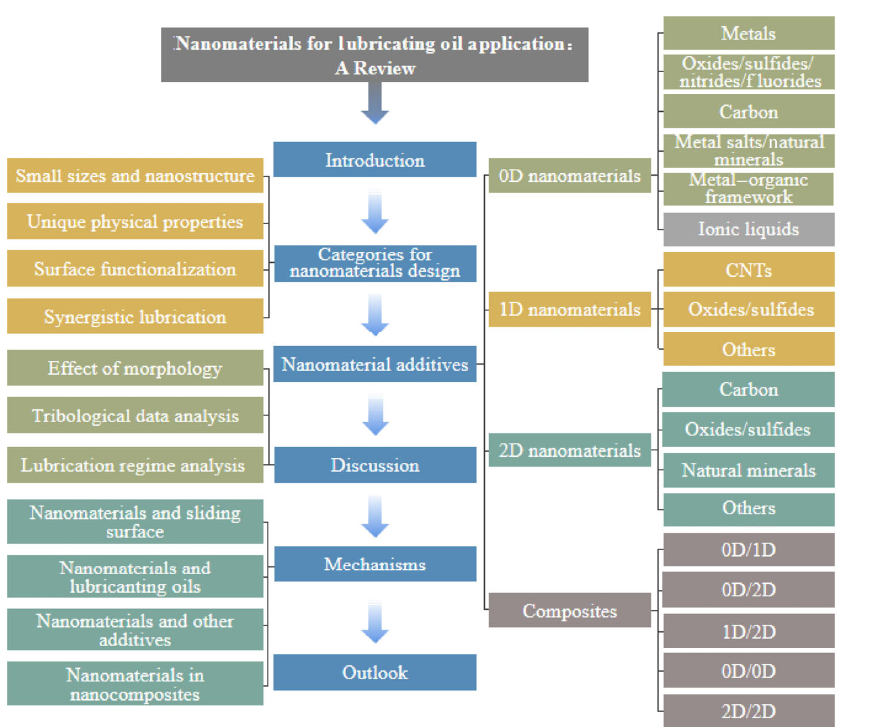
Fig. 2 Structures and contents of this review (Note: I onic liquids (ILs) do not fall within the scope of nanomaterial in theory, and their existence in this review is explained in Section 1; all the abbreviations are disclosed in the